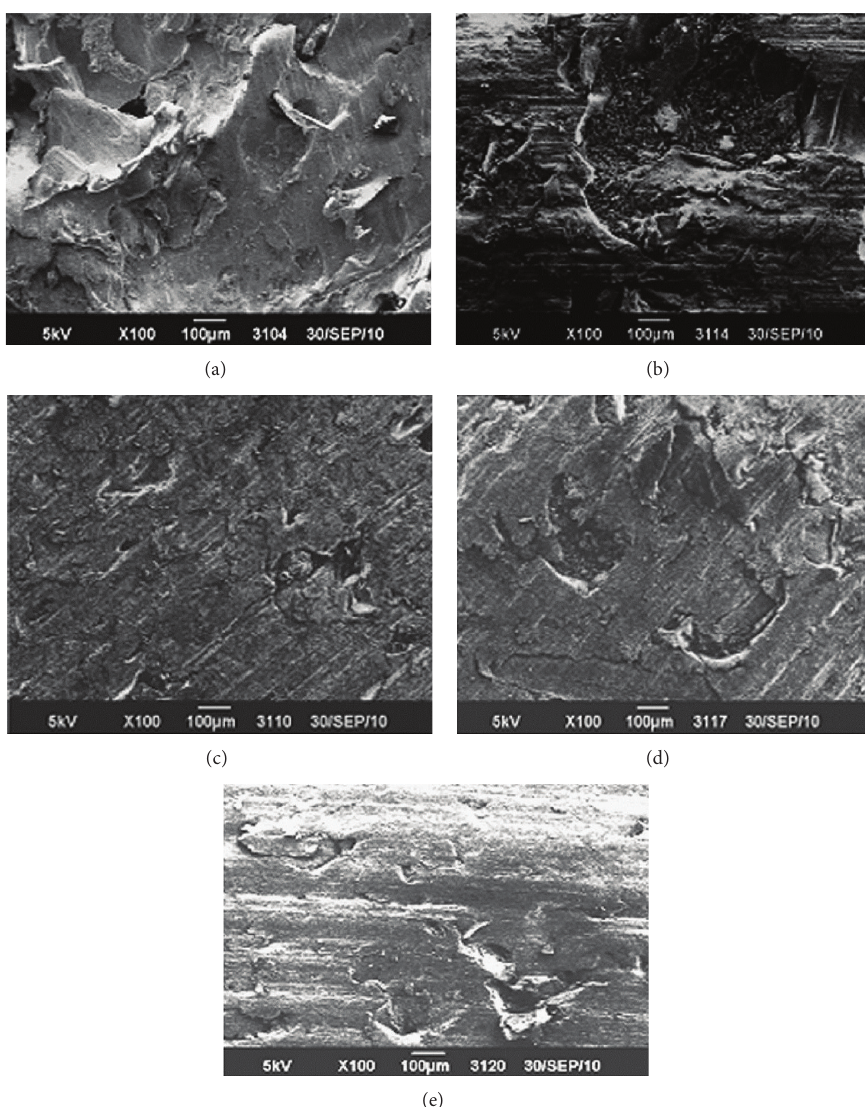
Figure 27: SEM micrographs of worn surfaces of foamed PVC without RH: (a) FPRH0; RH filled foamed PVC: (b) FPRH2 and (c) FPRH3; MAPP modified RH filled PVC composites: (d) FPTRH2 and (e) FPTRH3. (P = PVC; T = treated; F = foaming agent)